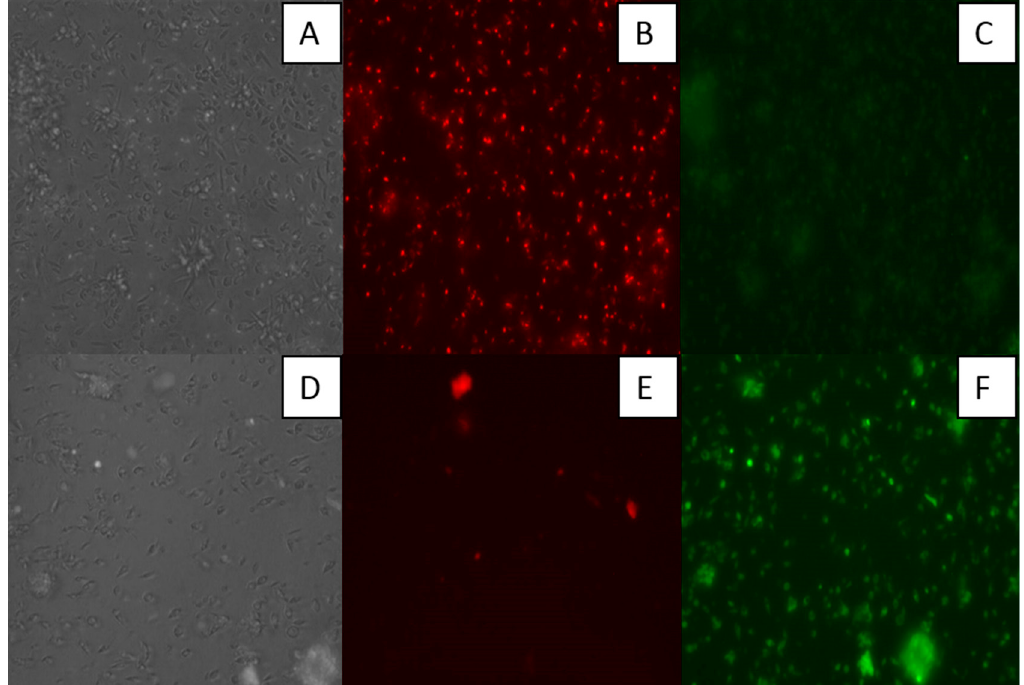
Figure 3. Effect of 7OSTS ( 2 ) on the mitochondrial potential in cells of L. amazonensis treated with the IC 90 for 24 h ( D ), ( E ) and ( F ). Negative control are non-compound-treated cells of L. amazonensis ( A ), ( B ) and ( C ). Due to a collapse in mitochondrial potential, the JC-1 dye in dimers (red) disappeared from mitochondria ( E ) and remained in the cytoplasm in its monomeric form, green fluorescence ( F ). ( A ), ( D ): visible light. ( B ), ( E ): (Ex: 531/40 Em: 593/40) Excitation/Emission (nm) for Red Fluorescent Protein (RFP). ( C ), ( F ): (Ex: 470/22 Em: 525/50) for Green Fluorescent Protein (GFP). Images taken by EVOS FL inverted microscope (Invitrogen) (40X).